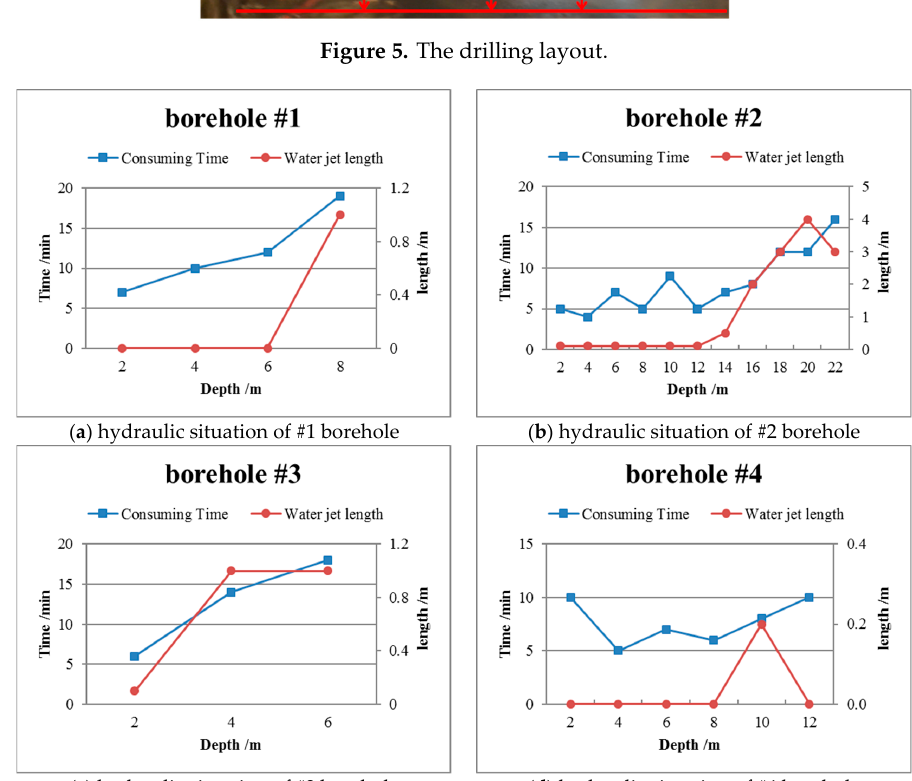
Figure 6. In-site drilling records.